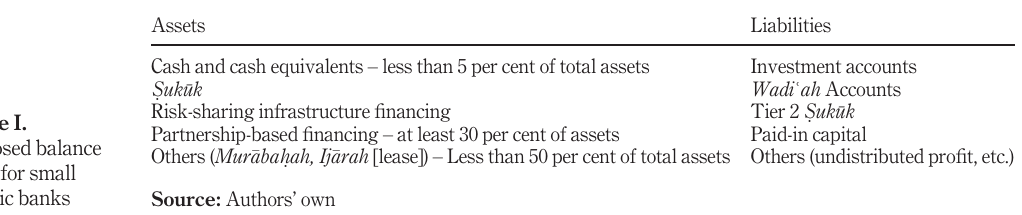
Table I. Proposed balance sheet for small Islamic